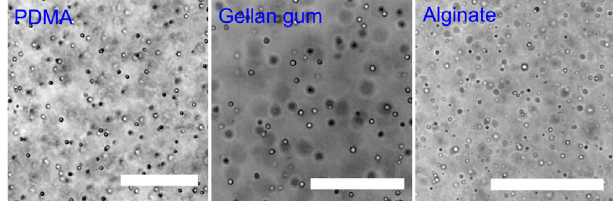
FIG. 6. Arrested isothermal phase separation in diverse hydro- gels. Here, anise oil droplets nucleated and grew in an ethanol- water mixture (i.e., the Ouzo effect). Micrographs of dispersed droplets in (a) PDMA, a covalently cross-linked gel; (b) gellan gum, a thermally set, physically cross-linked gel; and (c) alginate, an ionically cross-linked physical gel. All droplets are stable against coalescence. Droplets in PDMA and gellan are reason- ably monodisperse (see Ref. [37]). The scale bars are all 40 μ m